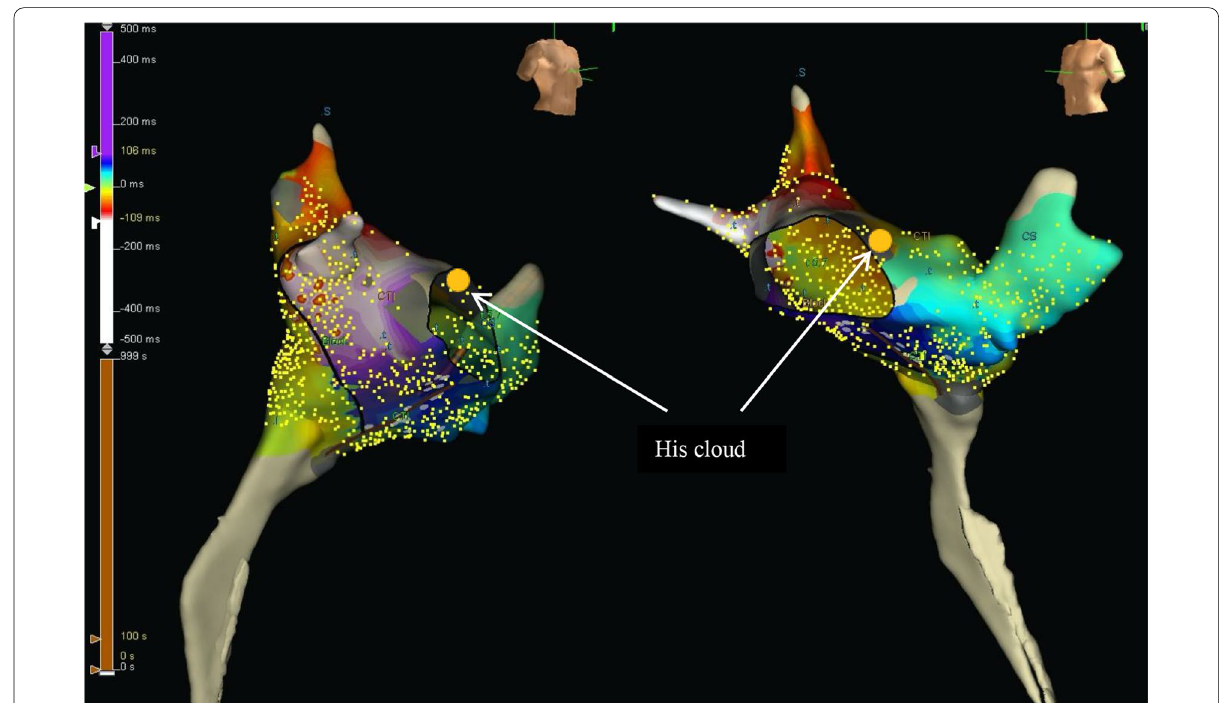
Fig. 4 The right anterior oblique (left image) and left anterior oblique views (right image) of the activation map were consistent with CTI-dependent clockwise right atrial flutter. The His Cloud (white arrows) was 16 mm away from the ablation site. The patient had history of atrioventricular septal defect required surgical repair as well as persistent left sided superior vena